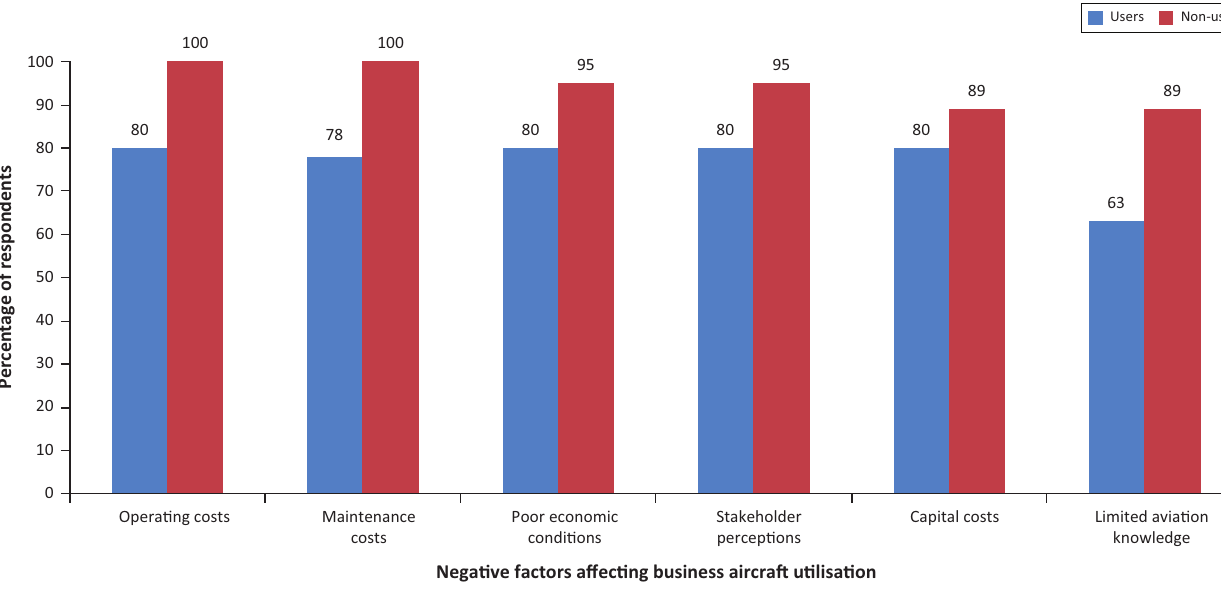
FIGURE 5: Comparison of business aircraft users and non-users regarding negative factors which affect utilisation ( n = 11 users; n = 19